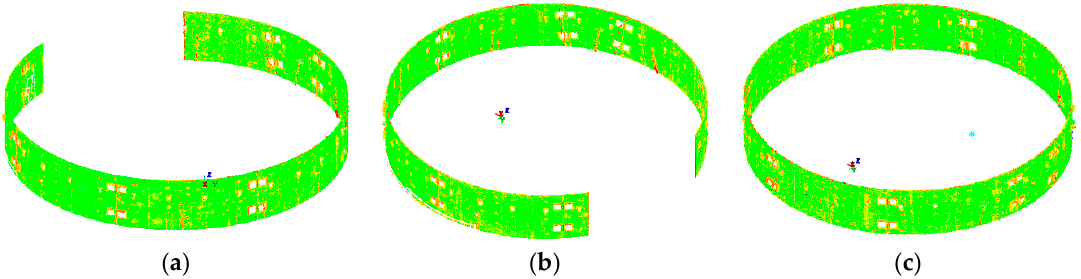
Figure 9. Registration process of the point cloud data from two laser scanning stations: ( a ) point cloud from laser scanning station A; ( b ) point cloud from laser scanning station B; and ( c ) registered full-ring point cloud.